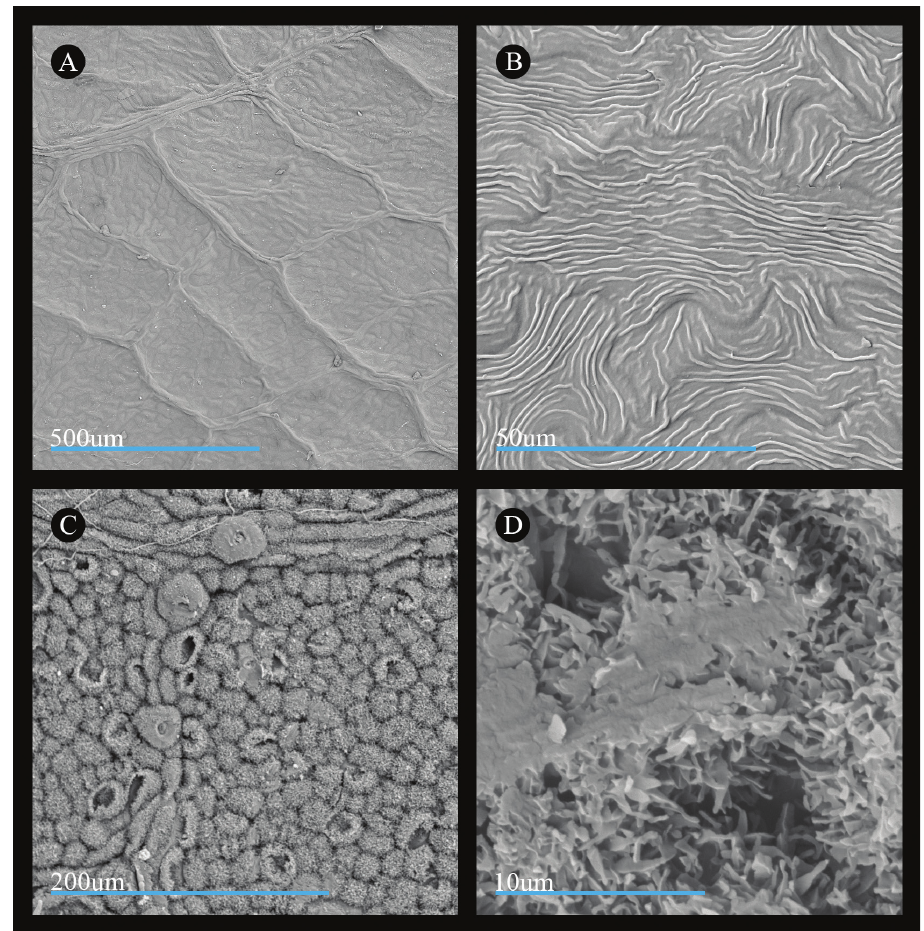
Figure 3. Micrographs of the leaf surfaces of Acer rubrum . A Adaxial surface showing cell shape and organi- zation ( Thieret 22942 ) B Adaxial surface showing cuticle ( Harris 2016-63 ) C , Abaxial surface showing cell shape and organization of cells and stomata ( Stevens 2617 ) D Abaxial surface showing cuticular wax ( Thieret 22942 ). All leaf materials are from specimens deposited at US, and parenthetical information in this legend refers to the collector name and number for the source